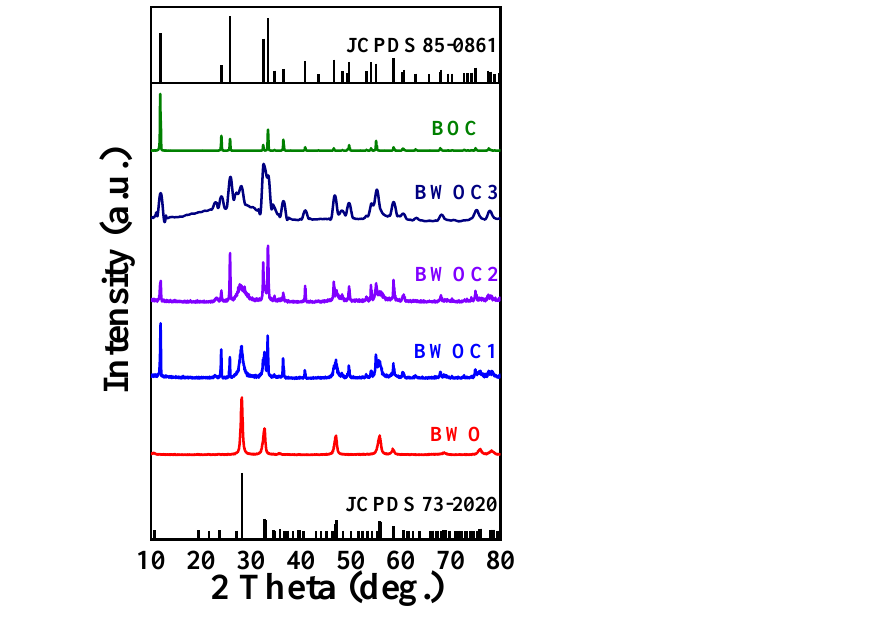
Figure 1. XRD patterns of the prepared samples: Bi 2 WO 6 (BWO), Bi 2 WO 6 /BiOCl composites (BWOC1 – 3), and BiOCl (BOC).